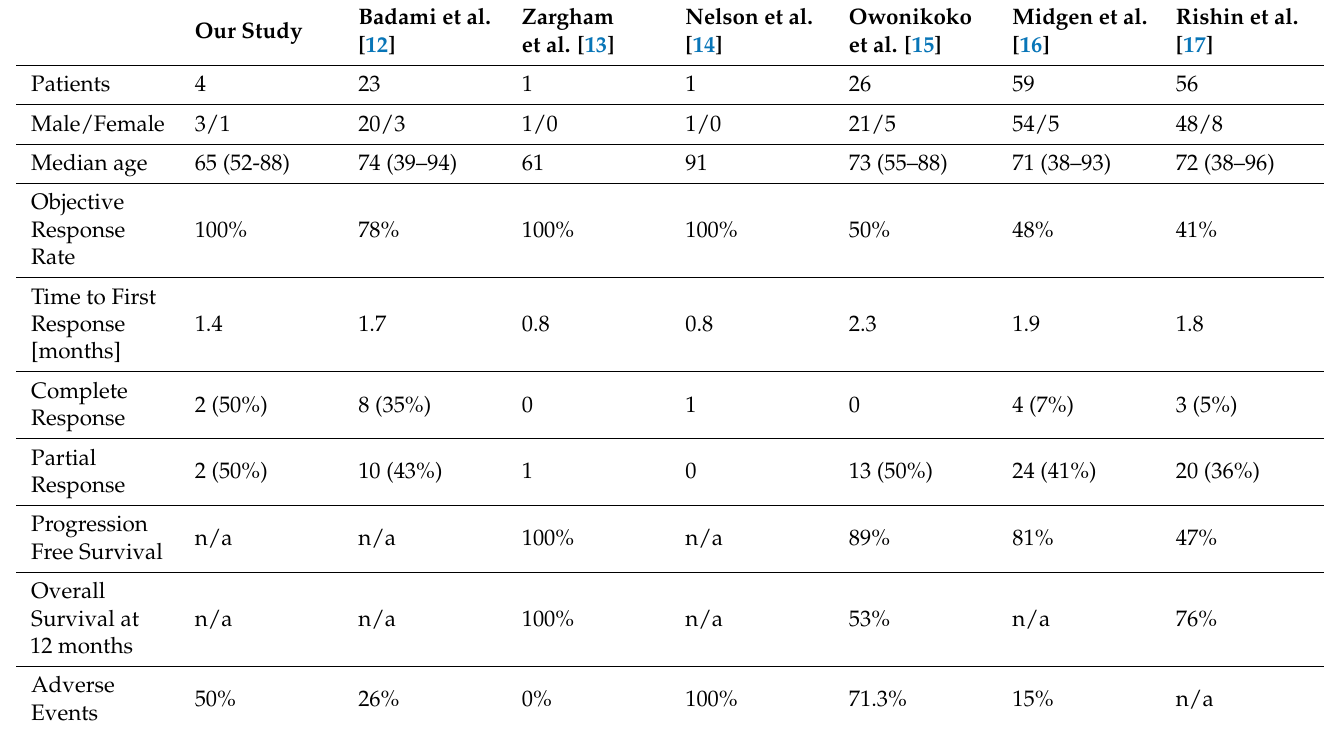
Table 1. Patient characteristics and tumor response summary from available